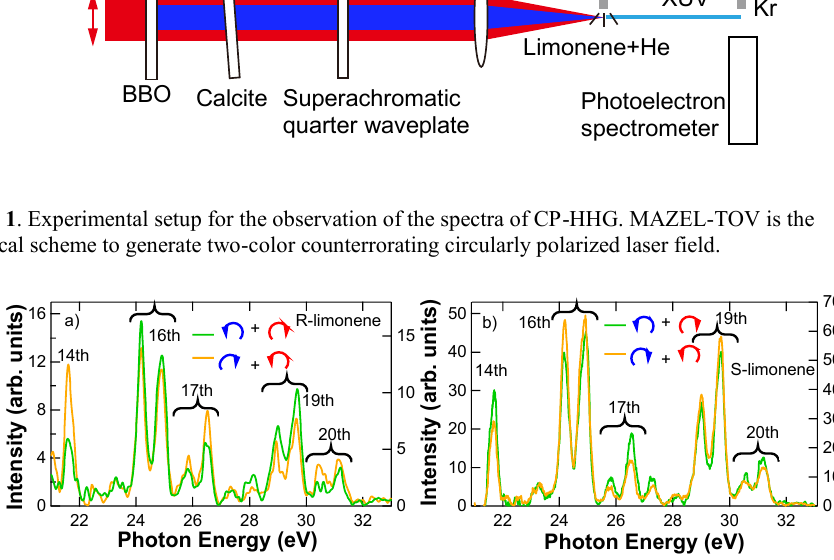
Fig. 2 . Spectra of circularly polarized high harmonics generated from a) R-limonene and b) S- limonene. The red and blue arrows indicate the direction of the polarization of the fundamental and the second harmonic used as the driving laser